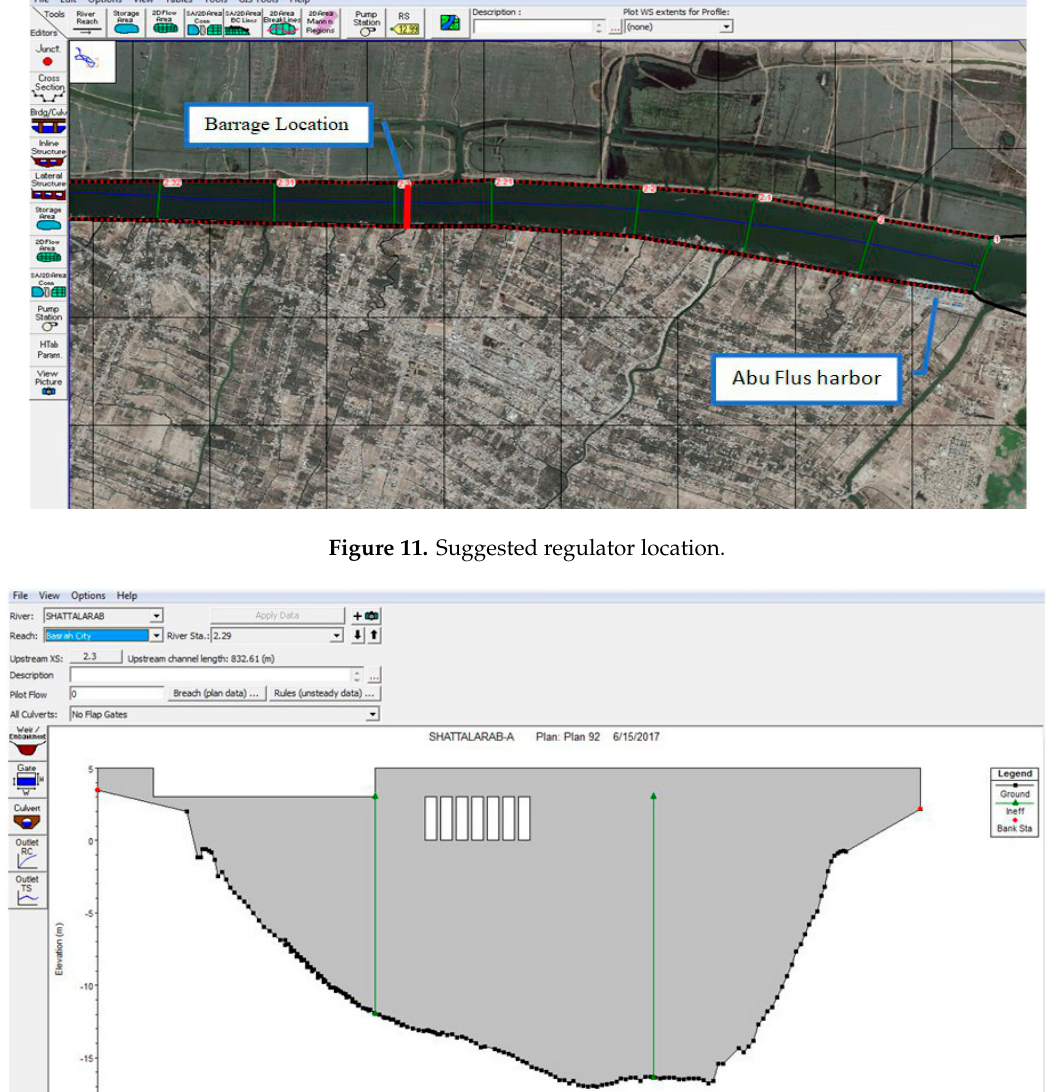
Figure 10. Lateral structure profile.